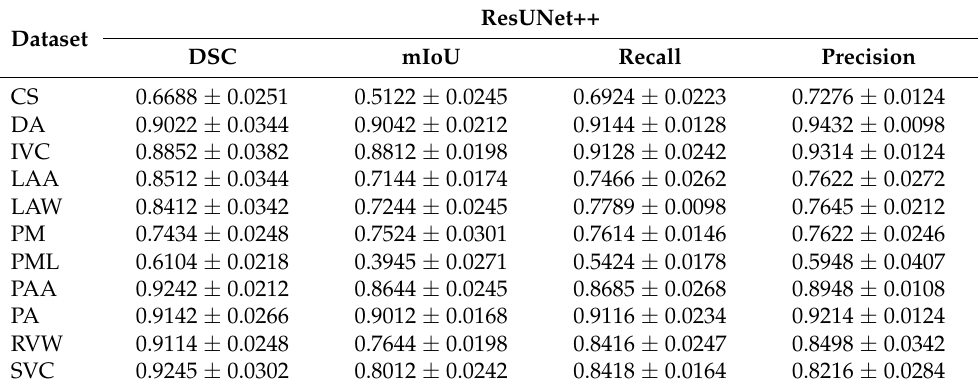
Table 5. Obtained segmentation results of different cardiovascular structures for ResUNet++ network architecture.